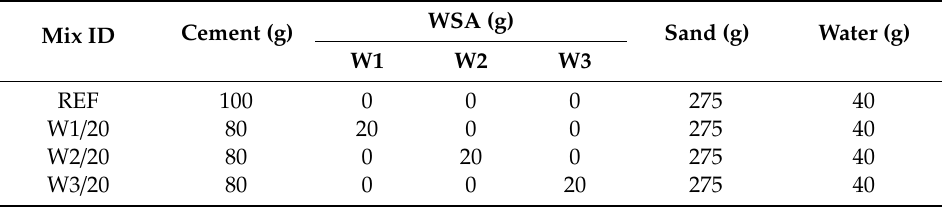
Table 2. Mix proportions of mortar